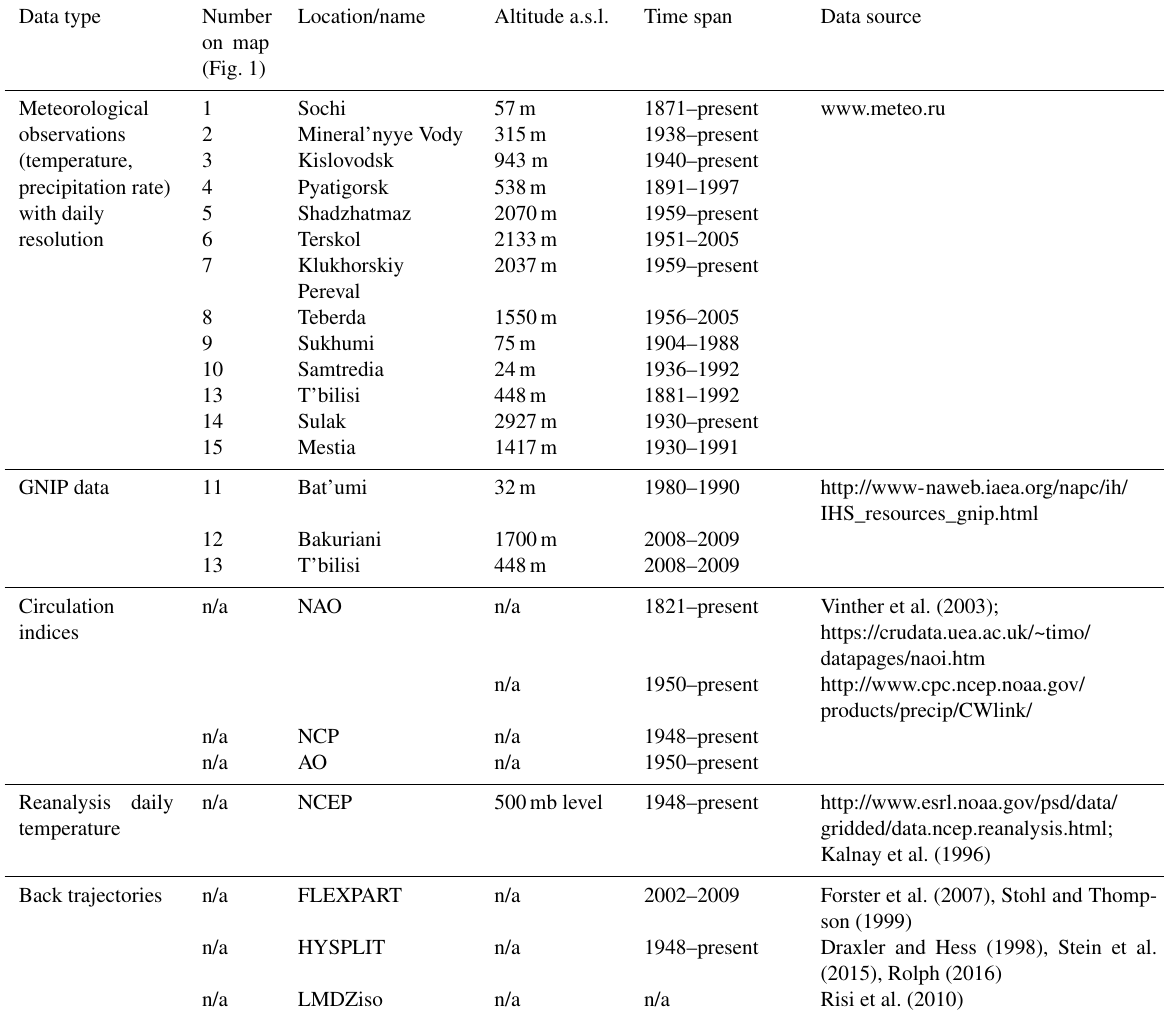
Table 1. Description of meteorological and instrumental data used in the